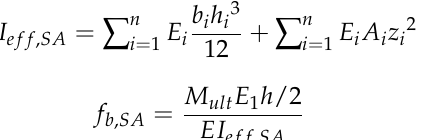
Figure 5. Histogram of MOR of solid timber specimens from the outer layers of E. nitens CLT for a population of 214 specimens.